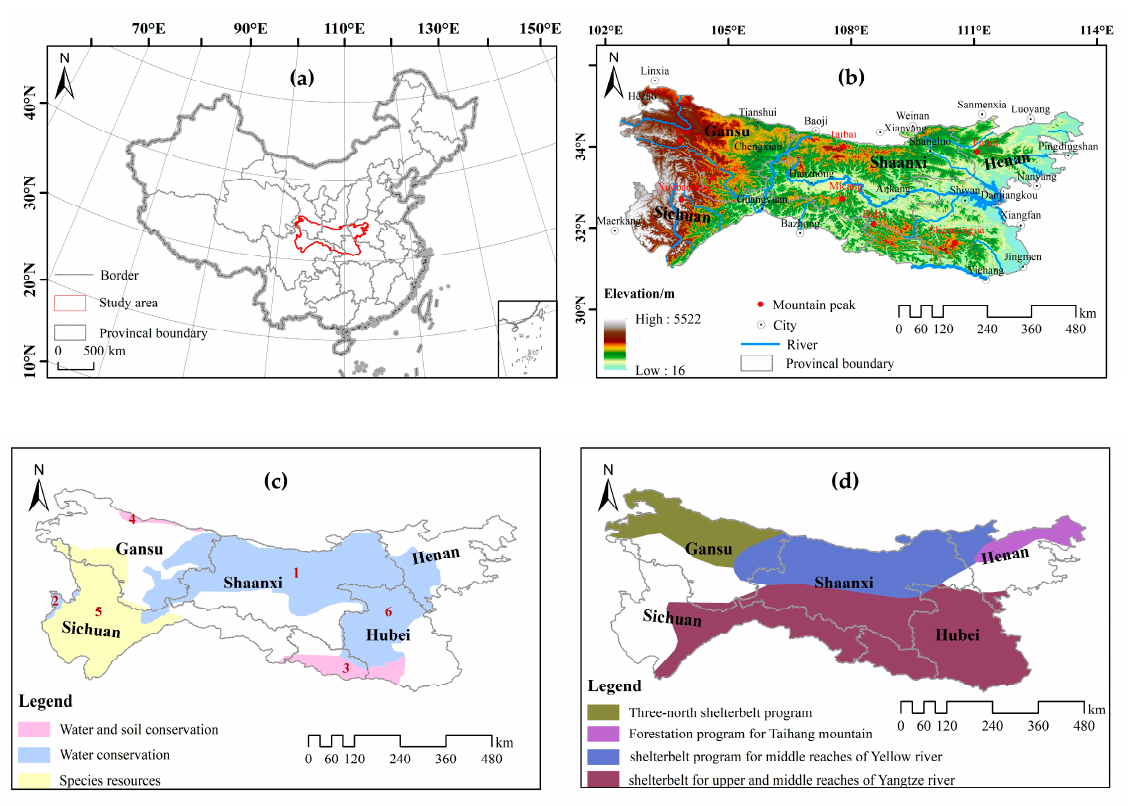
Figure 1. Overview of the QBM: ( a ) Geographical position; ( b ) Basic Elements: elevation, mountain peak, city location, and rivers; ( c ) Ecological Function Reserve (Number 1–6 represent the six ecological function reserves); ( d ) Forestry Engineering.